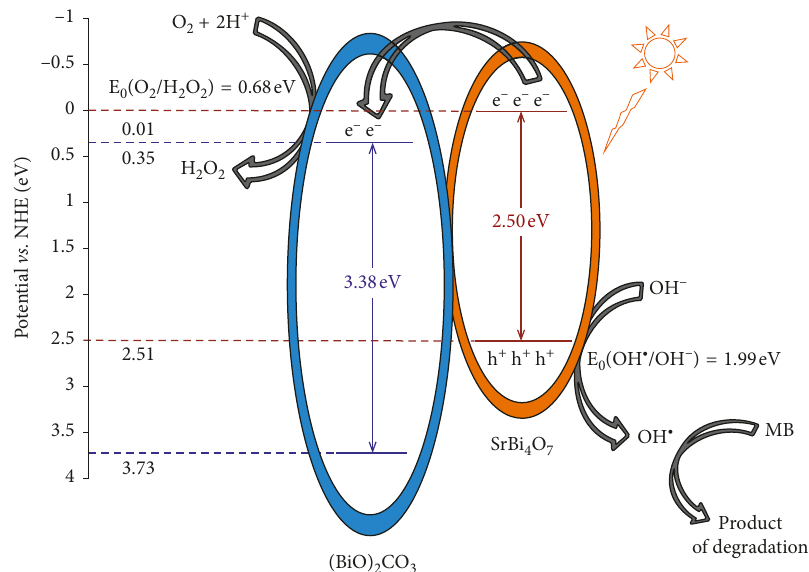
Figure 5: The possible degradation mechanism of MB over the prepared